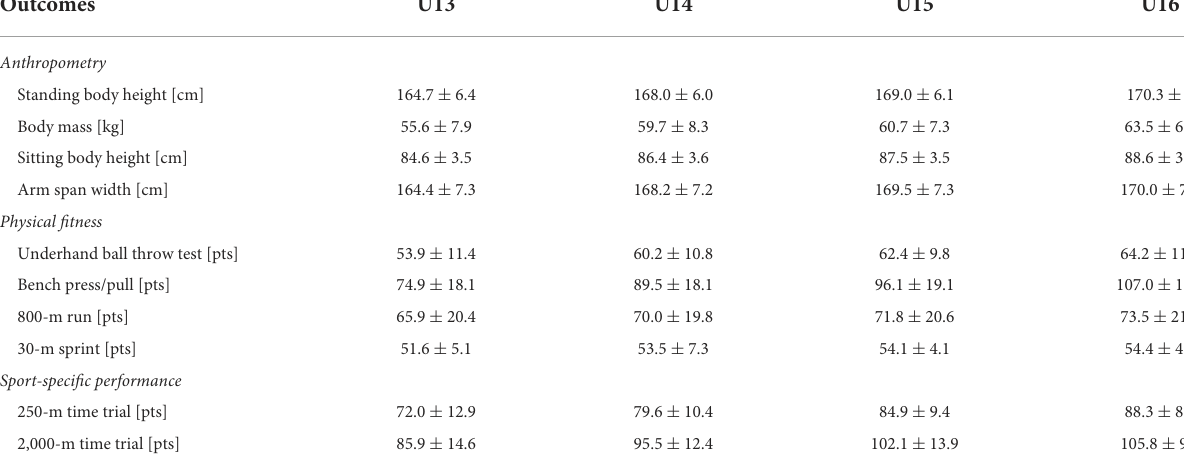
TABLE 1 Anthropometric, physical fitness and sport-specific performance measures in young female kayakers.